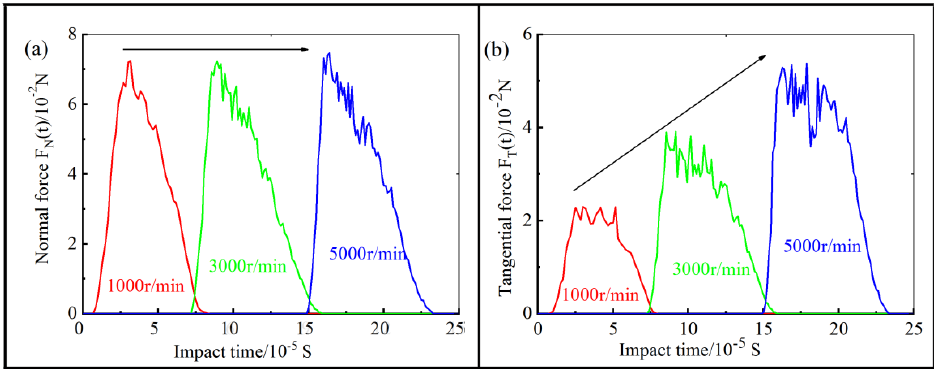
Figure 9. The simulation results of single abrasive grain during impact process: ( a ) the normal force F N ( t ); and ( b ) tangential force F T ( t ).